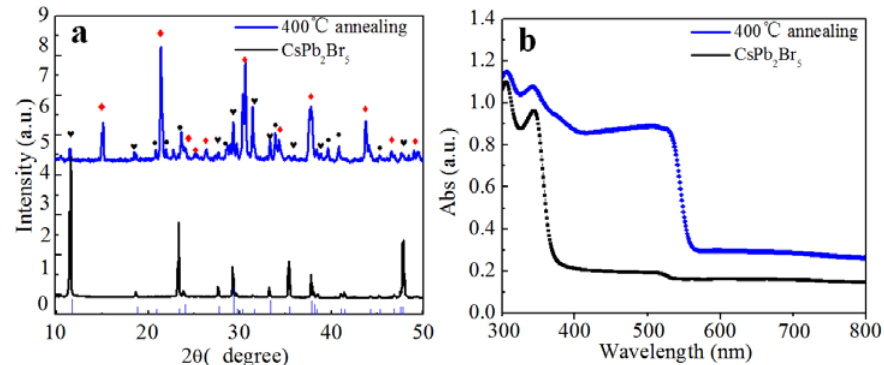
Figure 5. ( a ) XRD pattern, and ( b ) absorption spectra of CsPb 2 Br 5 particles after annealing at 400 °C temperature. In the XRD pattern, the red diamonds denotes the diffraction peak of CsPbBr 3 , the black dots denotes the diffraction peak of PbBr 2 and black hearts denote the diffraction peaks of CsPb 2 Br 5 .